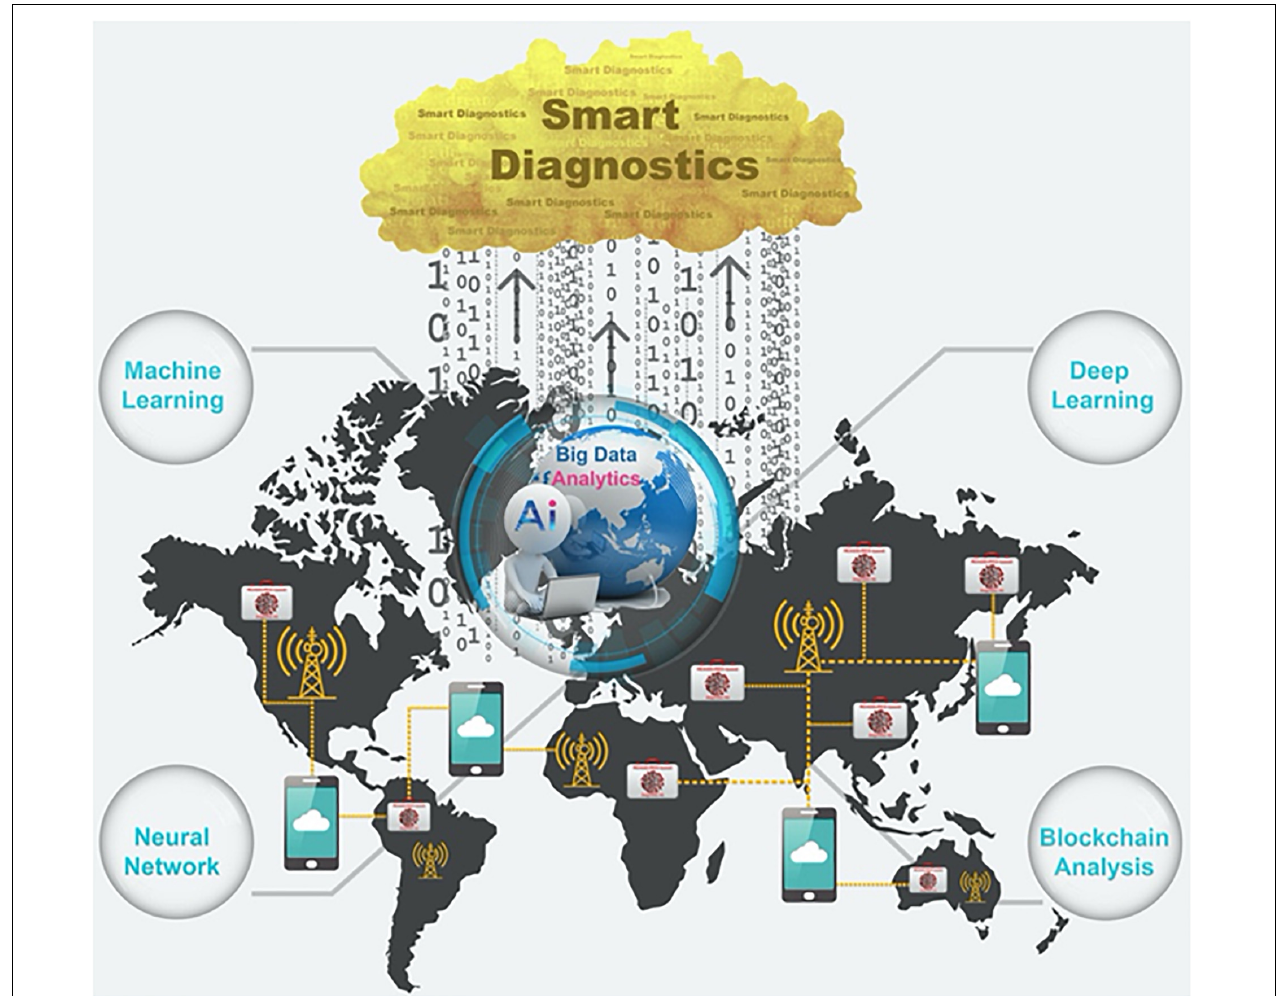
FIGURE 1 | Schematic representation: how to realize smart diagnostics in a pandemic scenario.